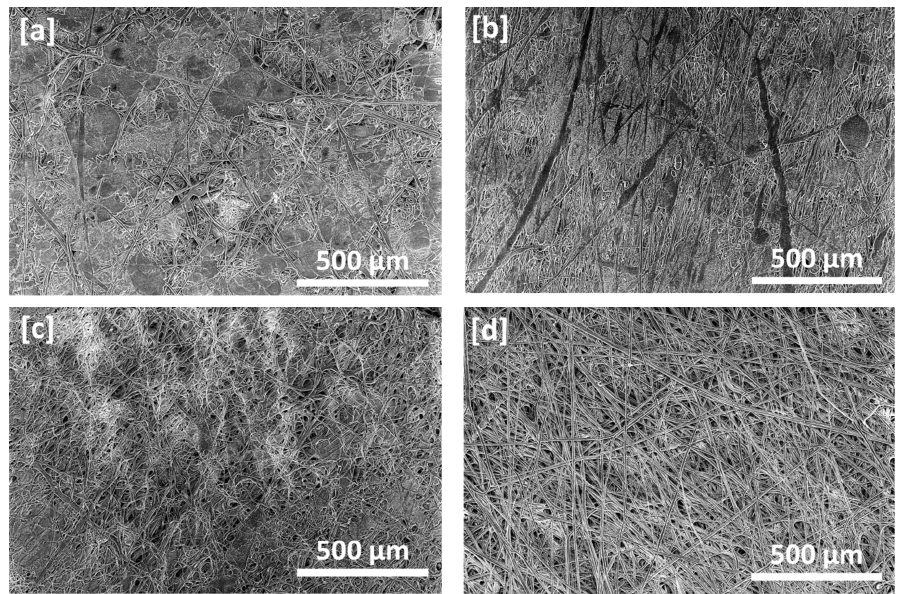
Figure 2. SEM micrographs of PVDF electrospun fiber membranes prepared at 30 kV from DMF/acetone solutions with different compositions of solvent mixtures: ( a ) control membrane DMF/acetone: 100/0, ( b ) DMF/acetone: 80/20, ( c ). DMF/acetone: 60/40 and ( d ) DMF/acetone: 50/50.